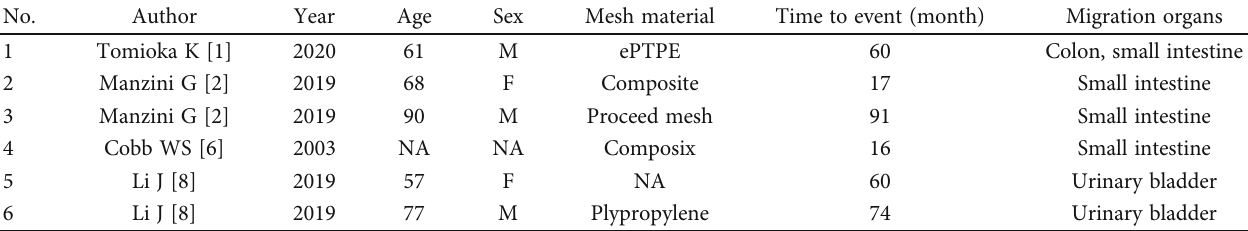
Table 2: Summary of cases in which the mesh used in abdominal incisional hernia migrated to adjacent organs.